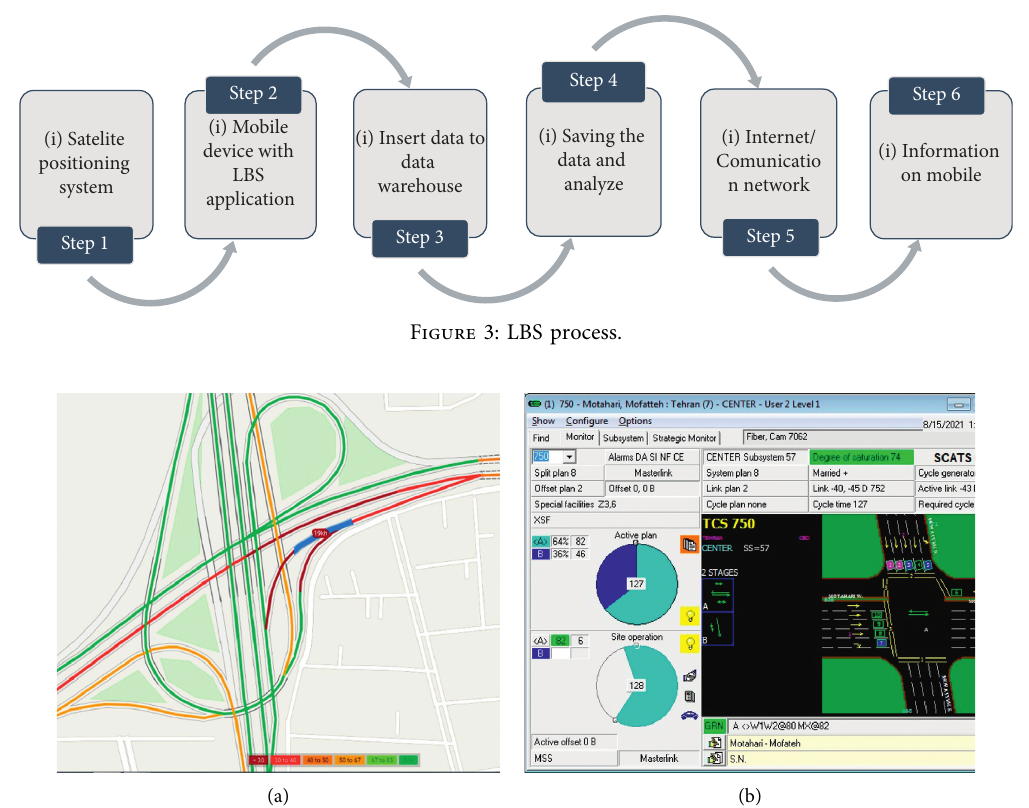
Figure 4: RISC Map View by Location-Based Service (LBS) data model (a), and SCATS software environment (b) for one sample (Motahhari-Mofatteh) used